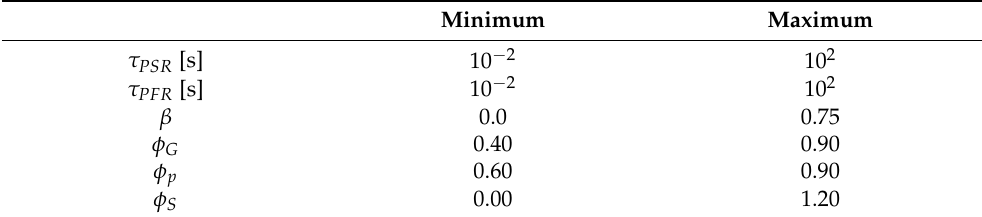
Table 1. The range of the parameters considered in this